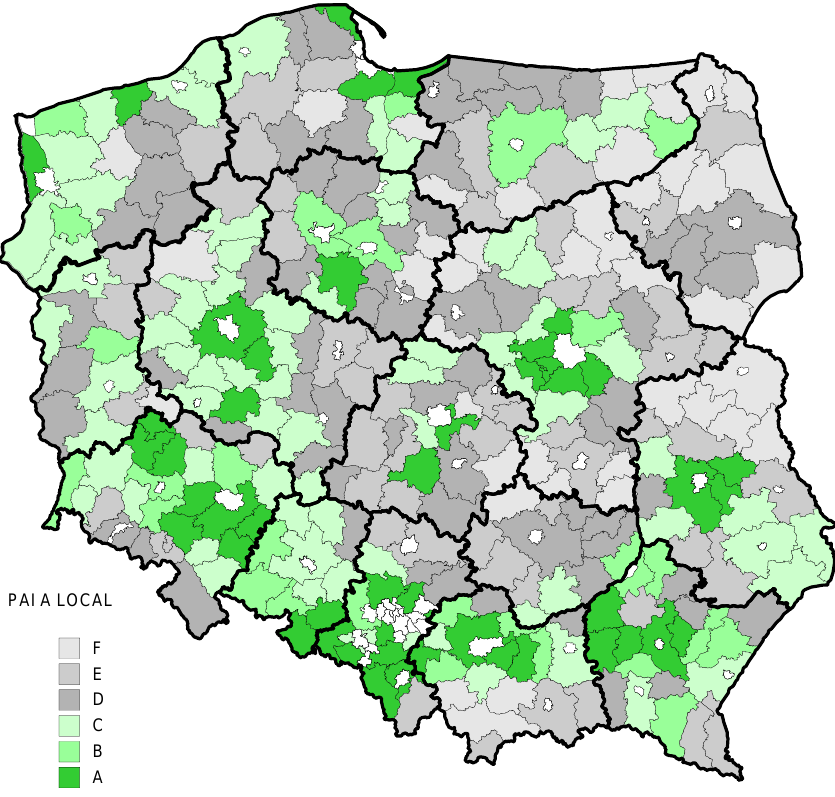
Figure 4. Spatial diversification of the potential investment attractiveness index for Section A enterprises at the local level (counties) in Poland in 2019 (PAI A LOCAL). White colour means cities with county rights, which are not covered by the study due to the lack of agricultural functions. Source: own research (using the program Map Viewer).